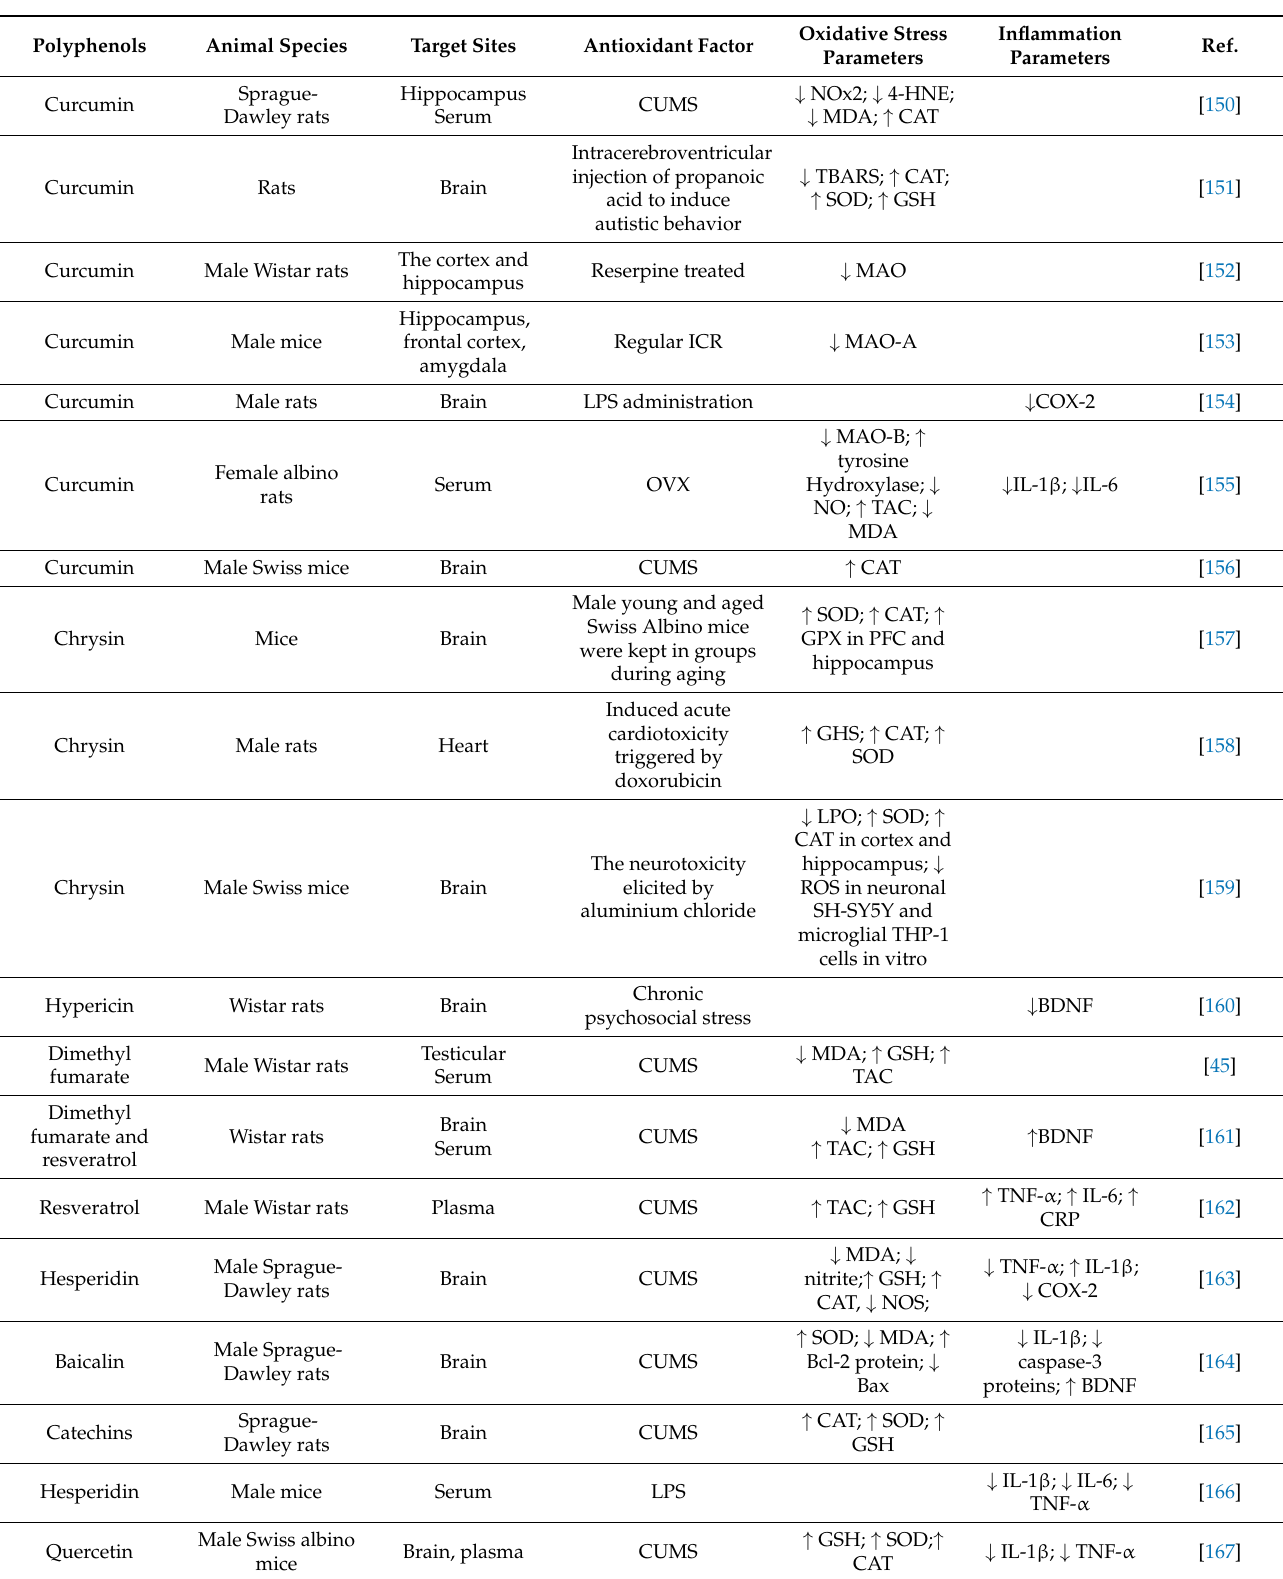
Table 3. The effect of polyphenols on oxidative stress in depression—review of studies on labora- tory